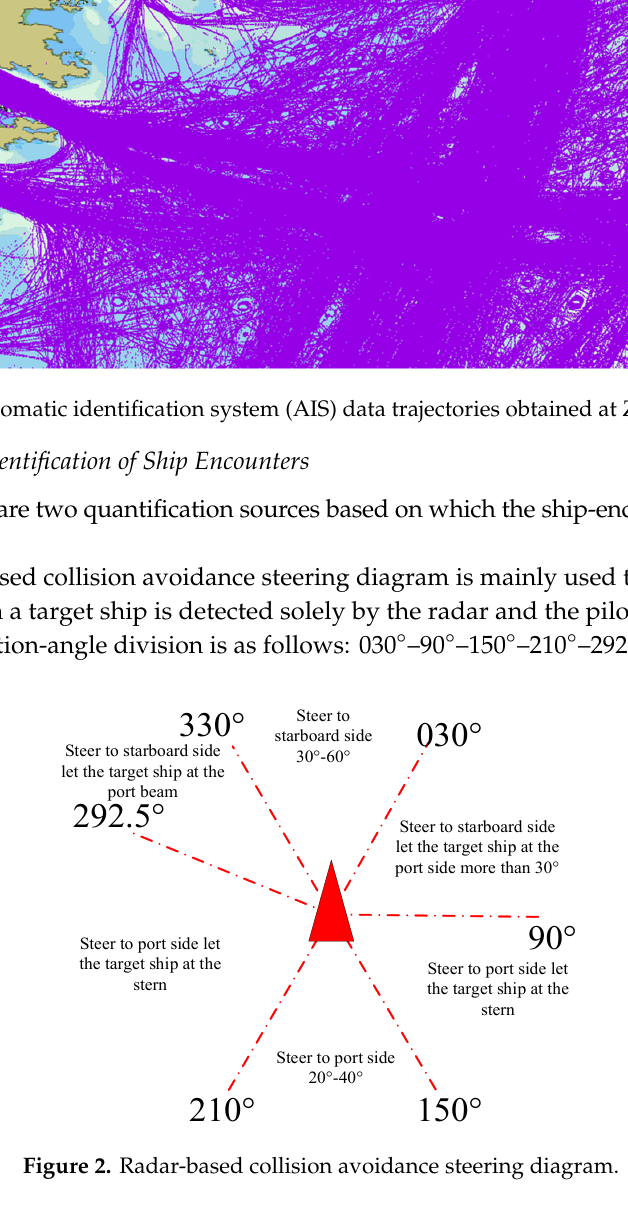
Figure 1. Automatic identification system (AIS) data trajectories obtained at Zhoushan Port.